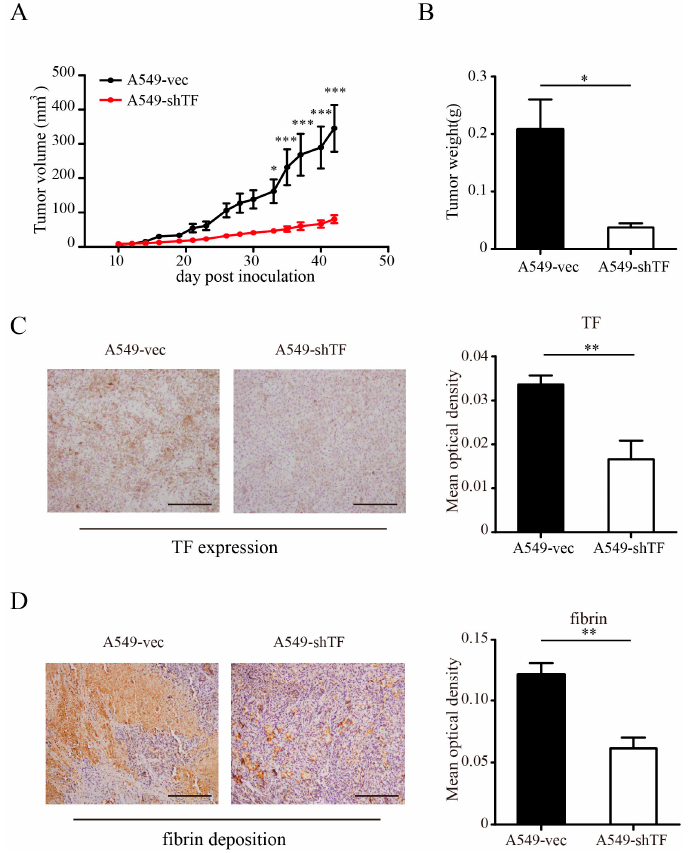
Figure 3. Effect of TF knockdown on tumor progression in vivo and local coagulation activation. A549-vec cells and A549-shTF cells were implanted into nude mice ( n = 5) via subcutaneous injection. Tumor volume ( A ) and tumor weight ( B ) are expressed as mean ± SEM; ( C ) tumor sections in xenograft model were subjected to immunostaining analysis for TF expression, ( left panel, bar = 100 µ m) and ( D ) fibrin deposition, ( left panel, bar = 100 μ m) and ( C ) statistics of the mean optical density of TF, ( right panel) and ( D ) fibrin staining, ( right panel) were shown ( n = 3). Data are expressed as mean ± SEM, * p < 0.05, ** p < 0.01, *** p < 0.001.